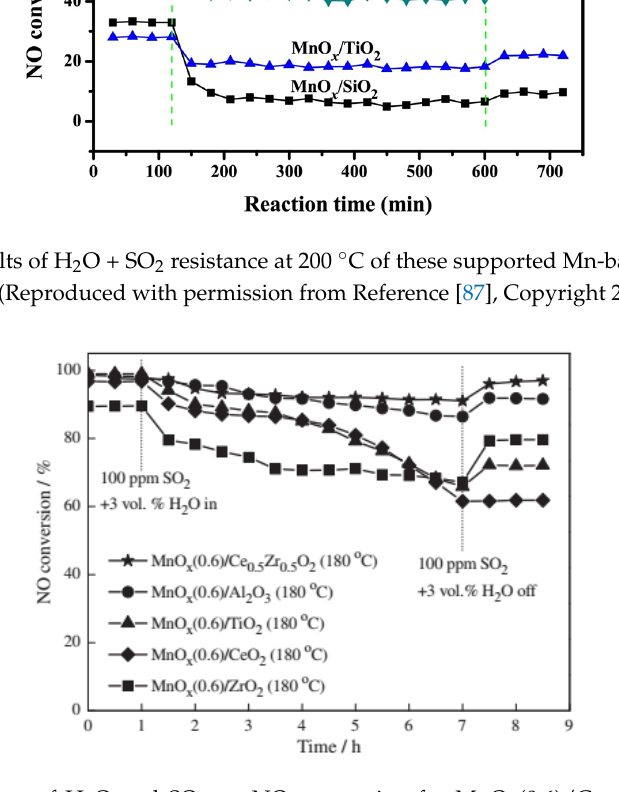
Figure 30. The effect of H 2 O and SO 2 on NO conversion for MnO x (0.6)/Ce 0.5 Zr 0.5 O 2 (Reaction